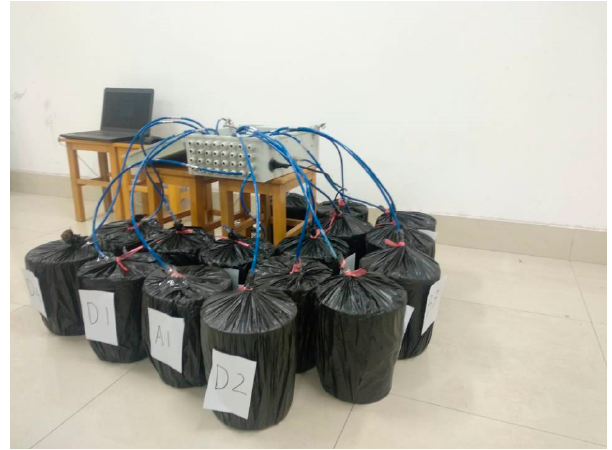
Figure 4. Self-volumetric deformation testing device for concrete.